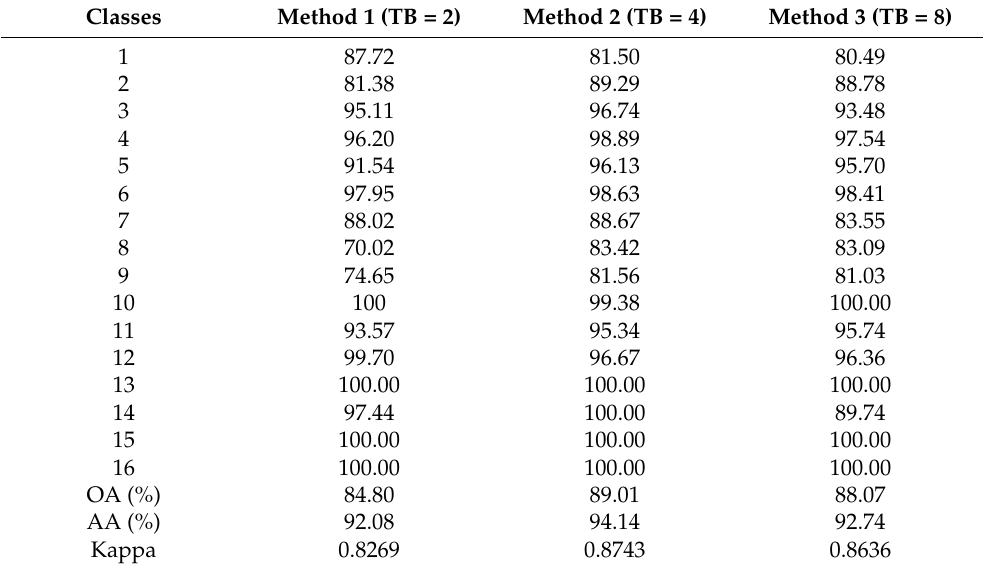
Table 11. Ablation study of various Transformer block numbers on Indian Pines